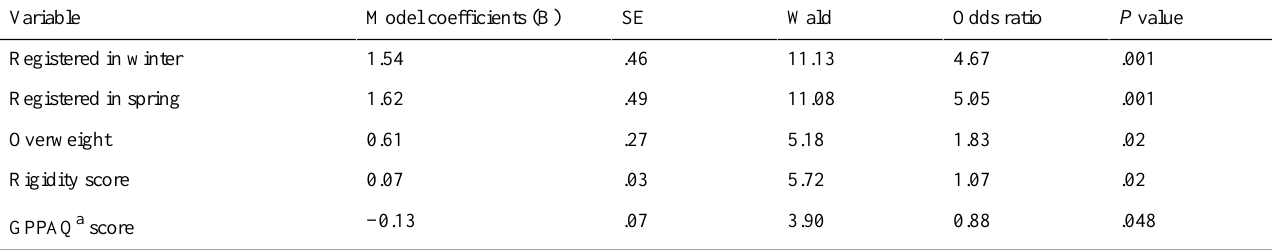
P valueOdds ratioWaldSEModel coefficients (B)Variable